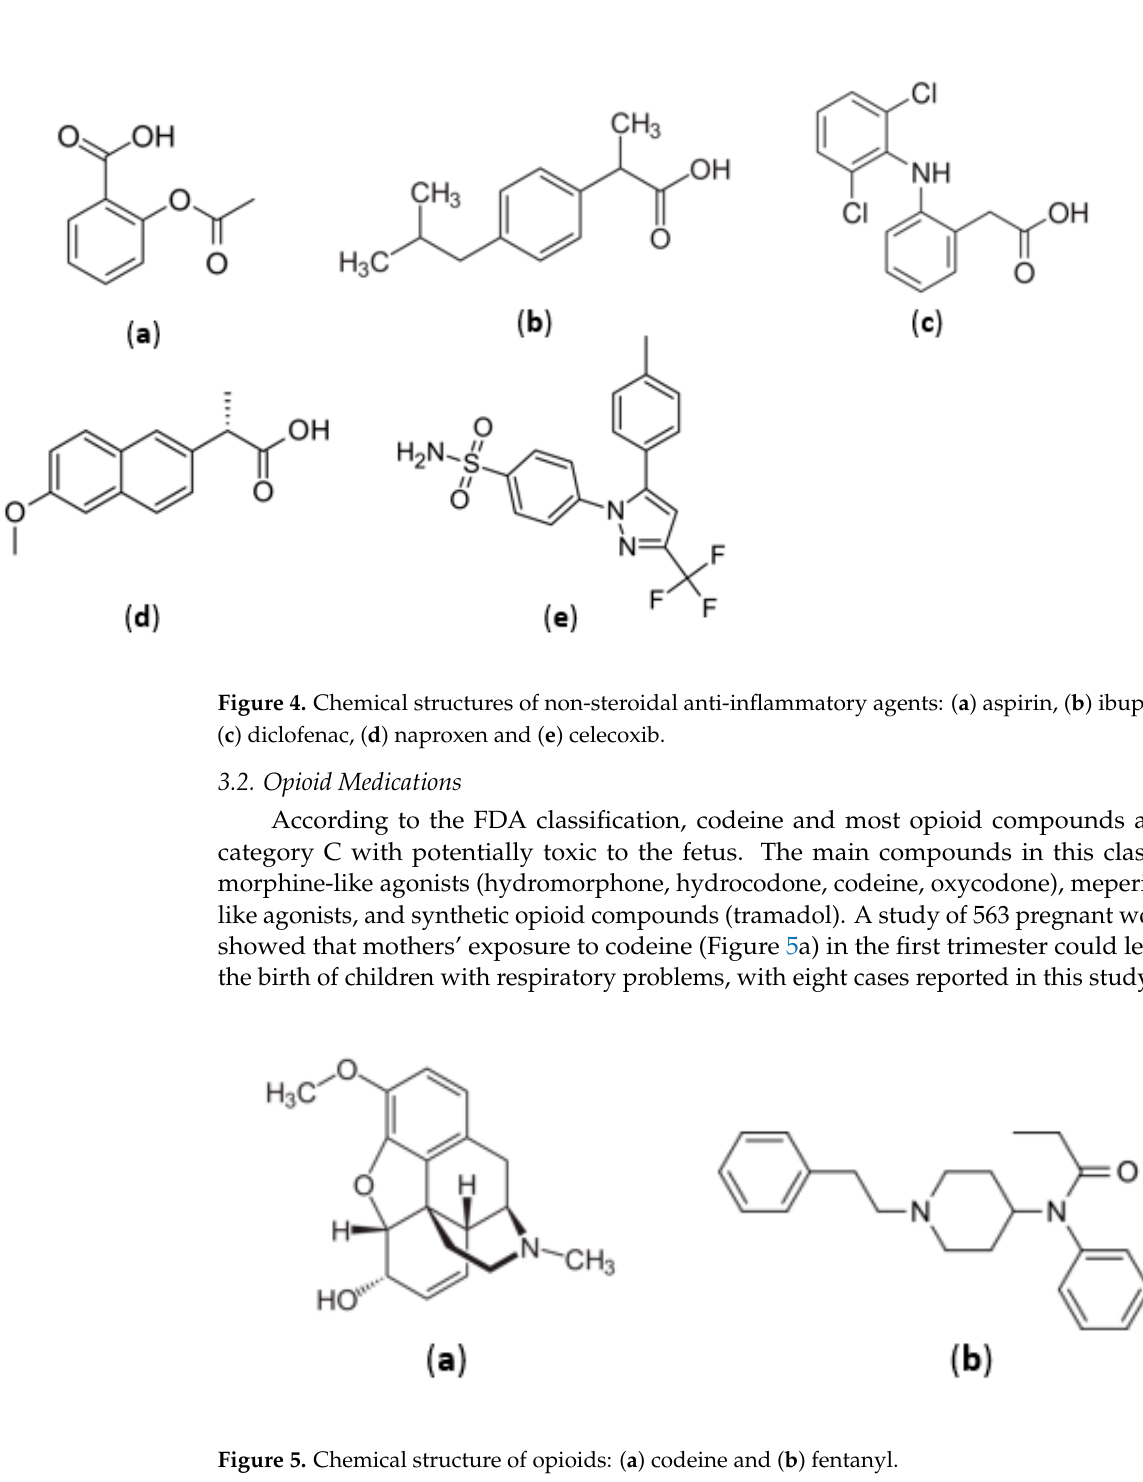
Figure 5. Chemical structure of opioids: ( a ) codeine and ( b ) fentanyl.